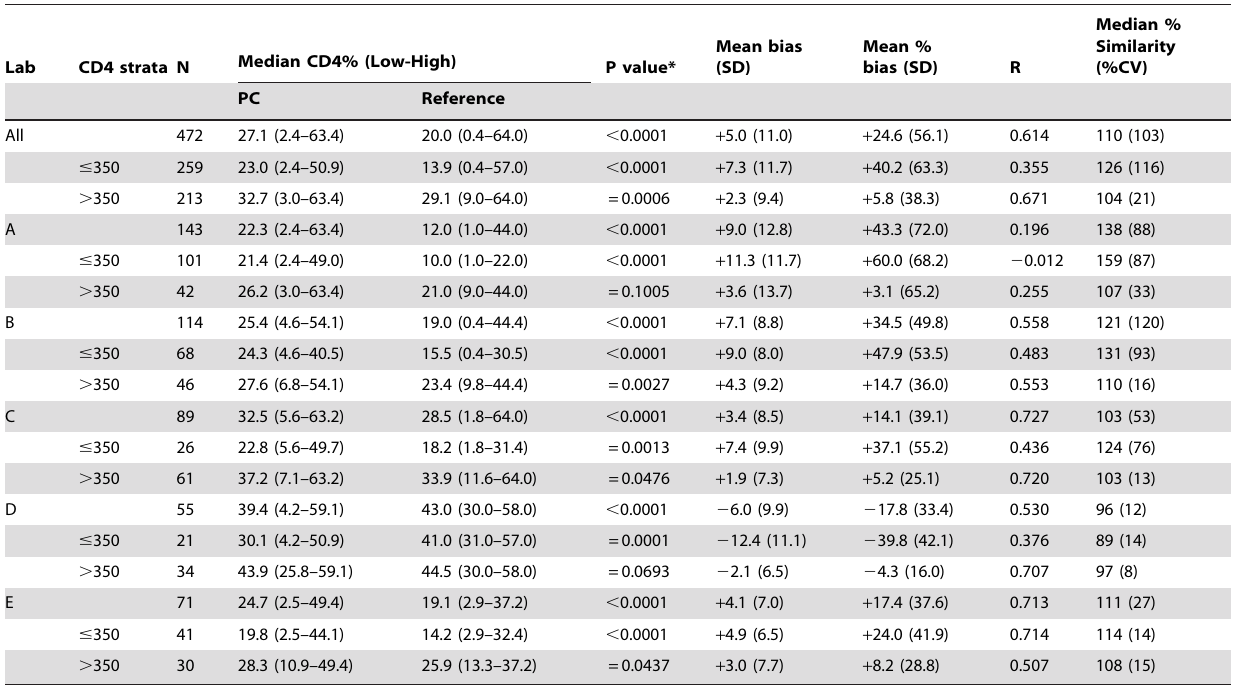
Table 3. Bias between reference method and PointCare Now (PC) for CD4 %.